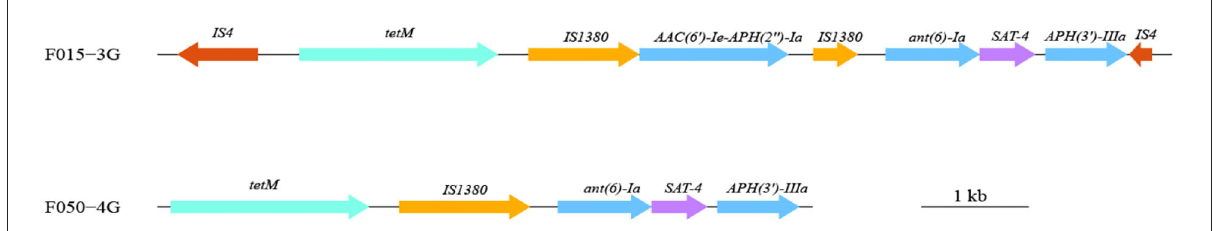
FIGURE3 Gene cluster composition in one A. butzleri (F050-4G) and one A. cryaerophilus (F015-3G) isolate. Different colors represent different genes or categories of the resistance gene. The length and direction of the arrows indicate the size and direction of genes.